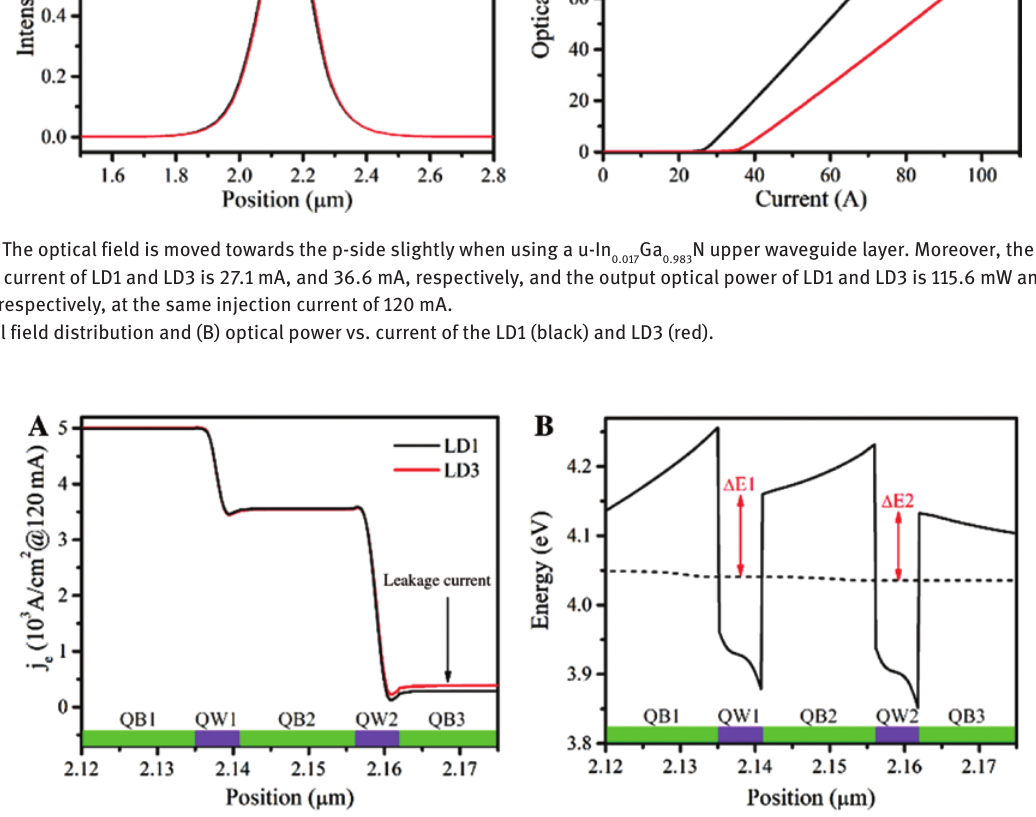
Figure 8: Shows the vertical electron current density distribution around the active region along the growth direction at an injecting current of 120 mA and the conduction band diagram. It can be seen that the leakage current of LD3 is larger than that of LD1, and the effective barrier height for the electrons in LD3 is smaller than that of LD1. Vertical electron current density distribution around the active region along the growth direction for LD1 (black) and LD3 (red) at an injecting current of 120 mA (A), and the conduction band diagrams (B). The short dot marks the quasi-Fermi levels of electron.